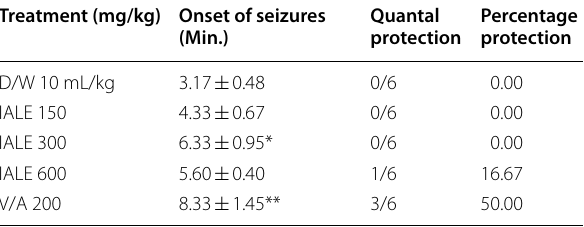
S.E.M., * p < 0.05, ** p < 0.01 as compared ± = = 6, = Ipomoea asarifolia leaf extract, V/A Valproic acid = =